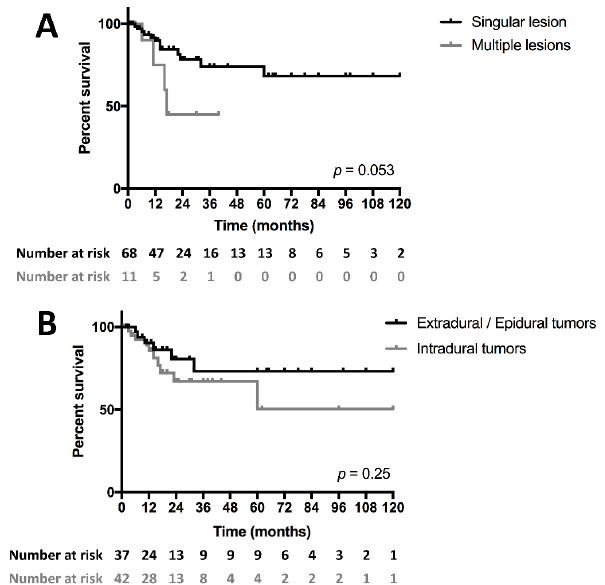
Figure 2. Kaplan–Meier survival curves of EwS patients with multiple intraspinal lesions at time of diagnosis compared to singular tumors ( A ) and with intradural compared with extradural/epidural tumors ( B ). Patients with multiple lesions tended to do substantially worse compared to those with singular tumors ( p = 0.052). Intradural tumors were more likely to be associated with a worse prognosis ( p = 0.25).